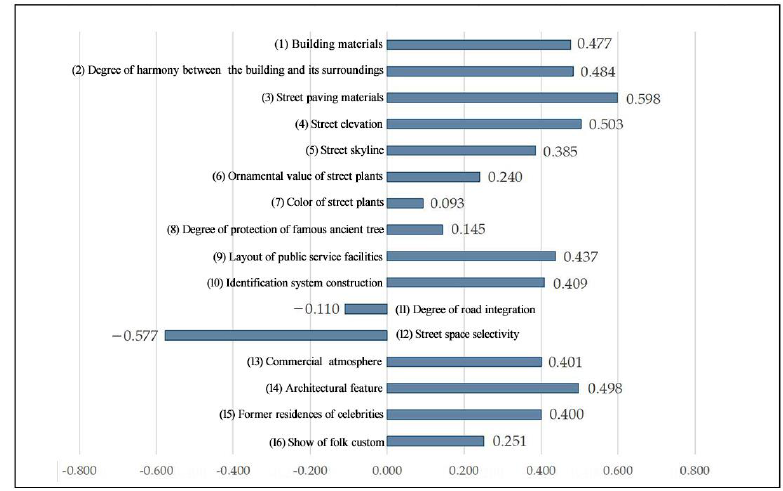
Figure 5. Evaluation values of landscape preference indicators for the “ One-character shaped ” spatial sample.